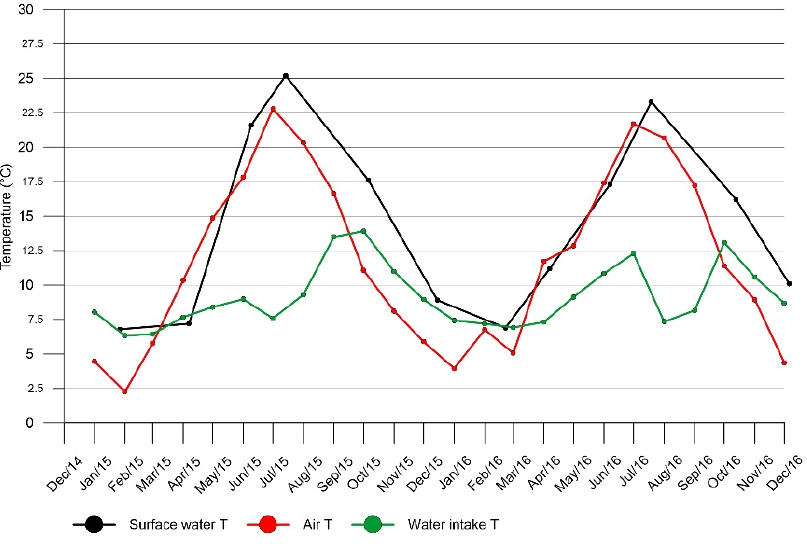
Figure 4. Temperature of surface water in the reservoir (black line), air at 2 m (red line), and water intake at the water treatment plant (green line) in 2015 and 2016.